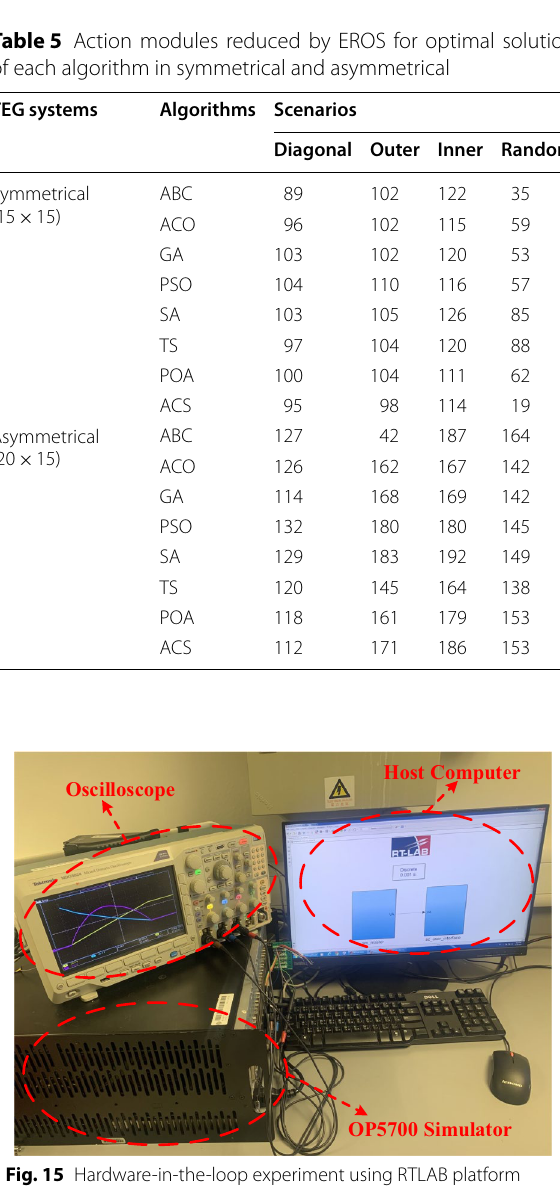
15) TEG system for simulation ×